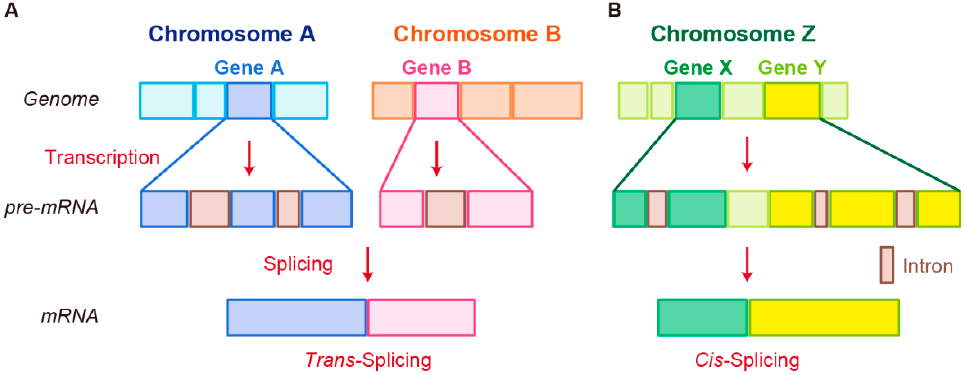
Figure 2. Schematic representation of fusion RNA formation by nonstructural chromosome rearrangements. ( A ) Trans-splicing. ( B ) Cis-splicing.